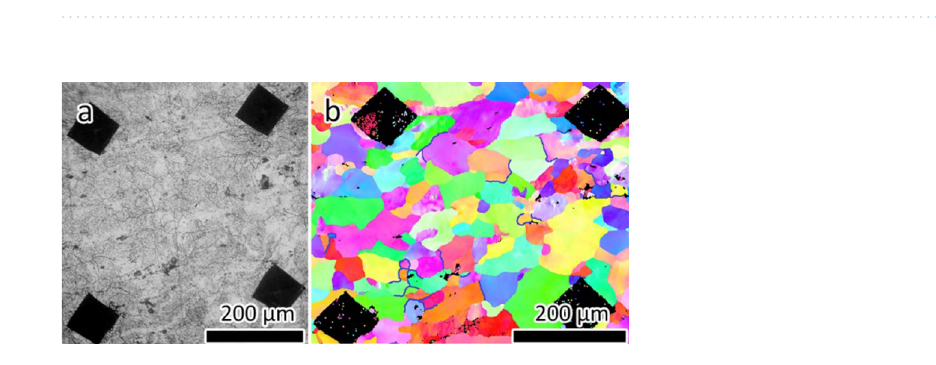
Figure 3. ( a ) Optical image showing the grain boundaries corroded after 600 s of acid exposure and ( b ) corroded grain boundaries highlighted by black lines in the IPF map. ( c ) Log-scale GND density map of the same region. ( d ), ( e ) Magnified images showing the corroded grain boundaries and the corresponding GND, respectively. The corroded grain boundary is highlighted in black and indicated by an arrow in ( d ). Arrows in ( e ) indicate regions of high GND density.